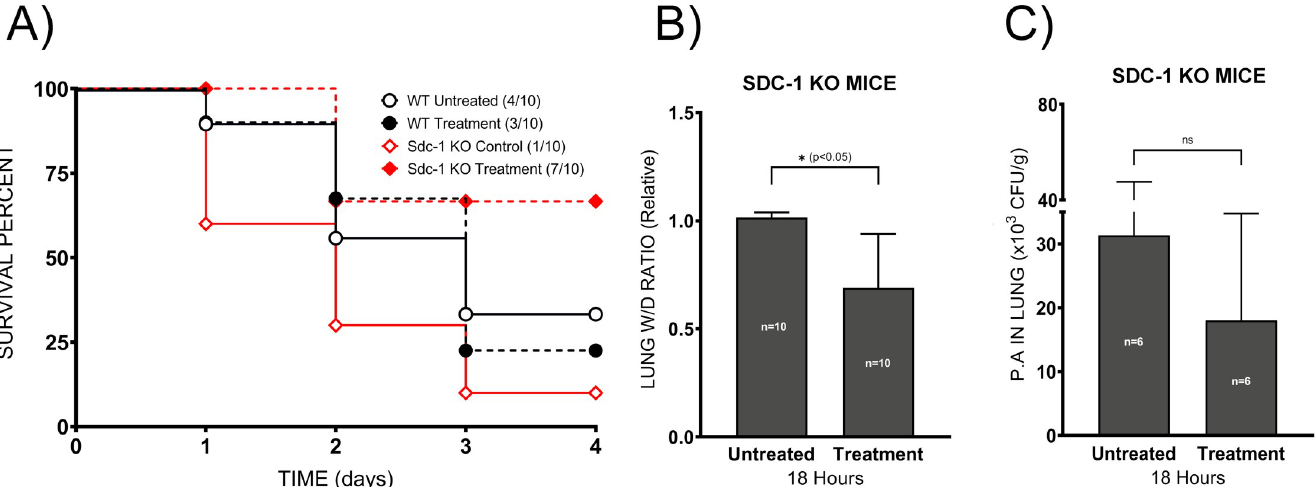
Fig 4. Administration of HMW-SH improves survival of septic Sdc-1 KO mice. The therapeutic effect of HMW-SH was tested in WT and Sdc-1 KO mice by intraperitoneal injection of HMW-SH at 4 hours after the induction of sepsis, and their survival was monitored for 96 hours (10 mice per group) (A). To compare the lung water contents of the septic Sdc-1 KO mice that received vehicle or HMW-SH administration, lung wet/dry weight ratio was calculated (10 mice per group) (B). Bacterial number in the lung tissue was determined 18 hours after the induction of sepsis in Sdc-1 KO mice with or without HMW-SH administration (6 mice per group) (C). Data are expressed as mean ± SD ( � p < 0.05).